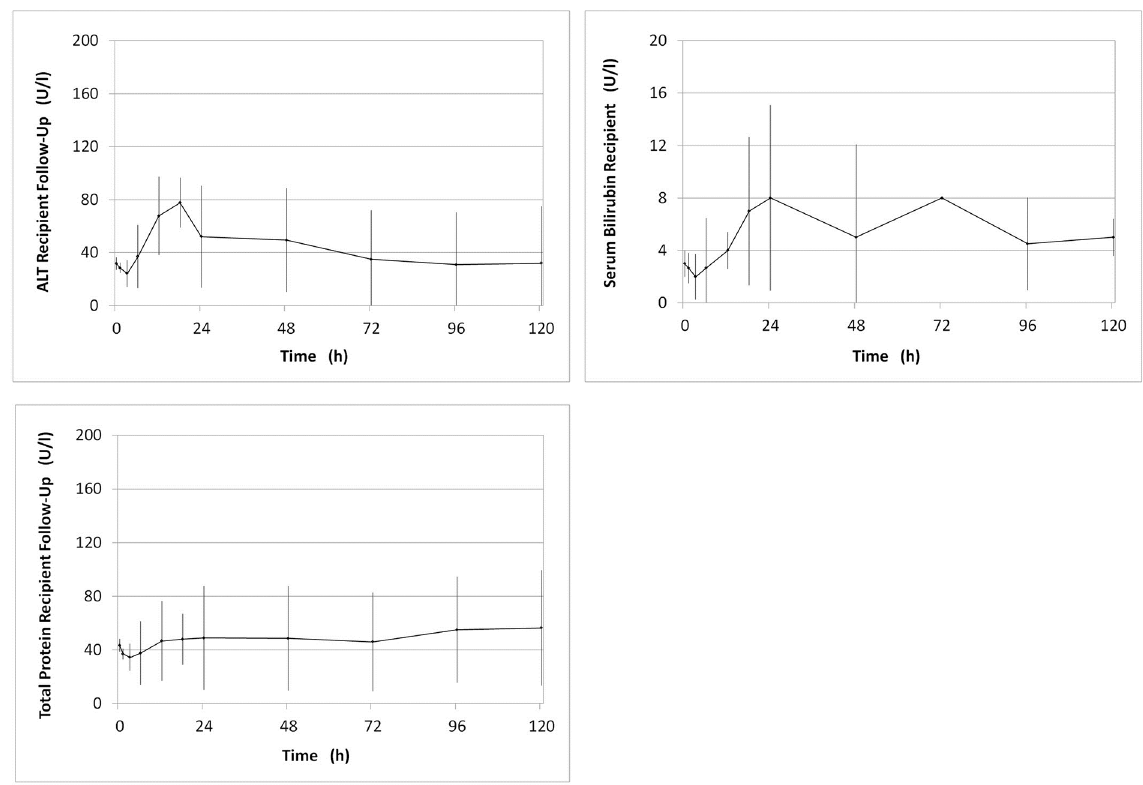
Fig 8. Post-transplant markers of cellular injury. (A) ALT (U/l), (B) bilirubin(mg/dl) * , (C) total protein (mg/dl) measuredin serum during5 days of follow-upafter orthotropicliver transplantation ± SD. * In one pig autopsy revealedan anastomoticleak from the common bile duct. Serum levels of bilirubinwere increasedto above20 mg/dl. Bilirubindata from this pig were excluded.